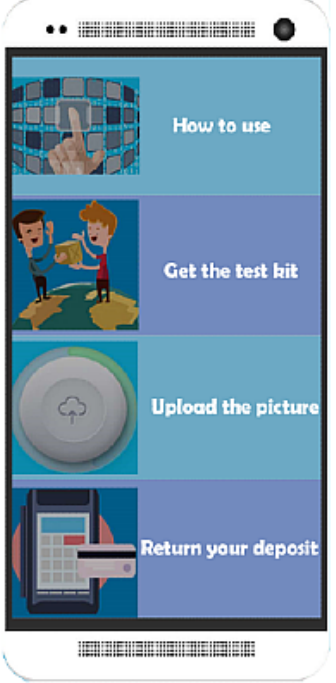
Figure 1. Interface of the “Mailing rapid test reagent kit” app.